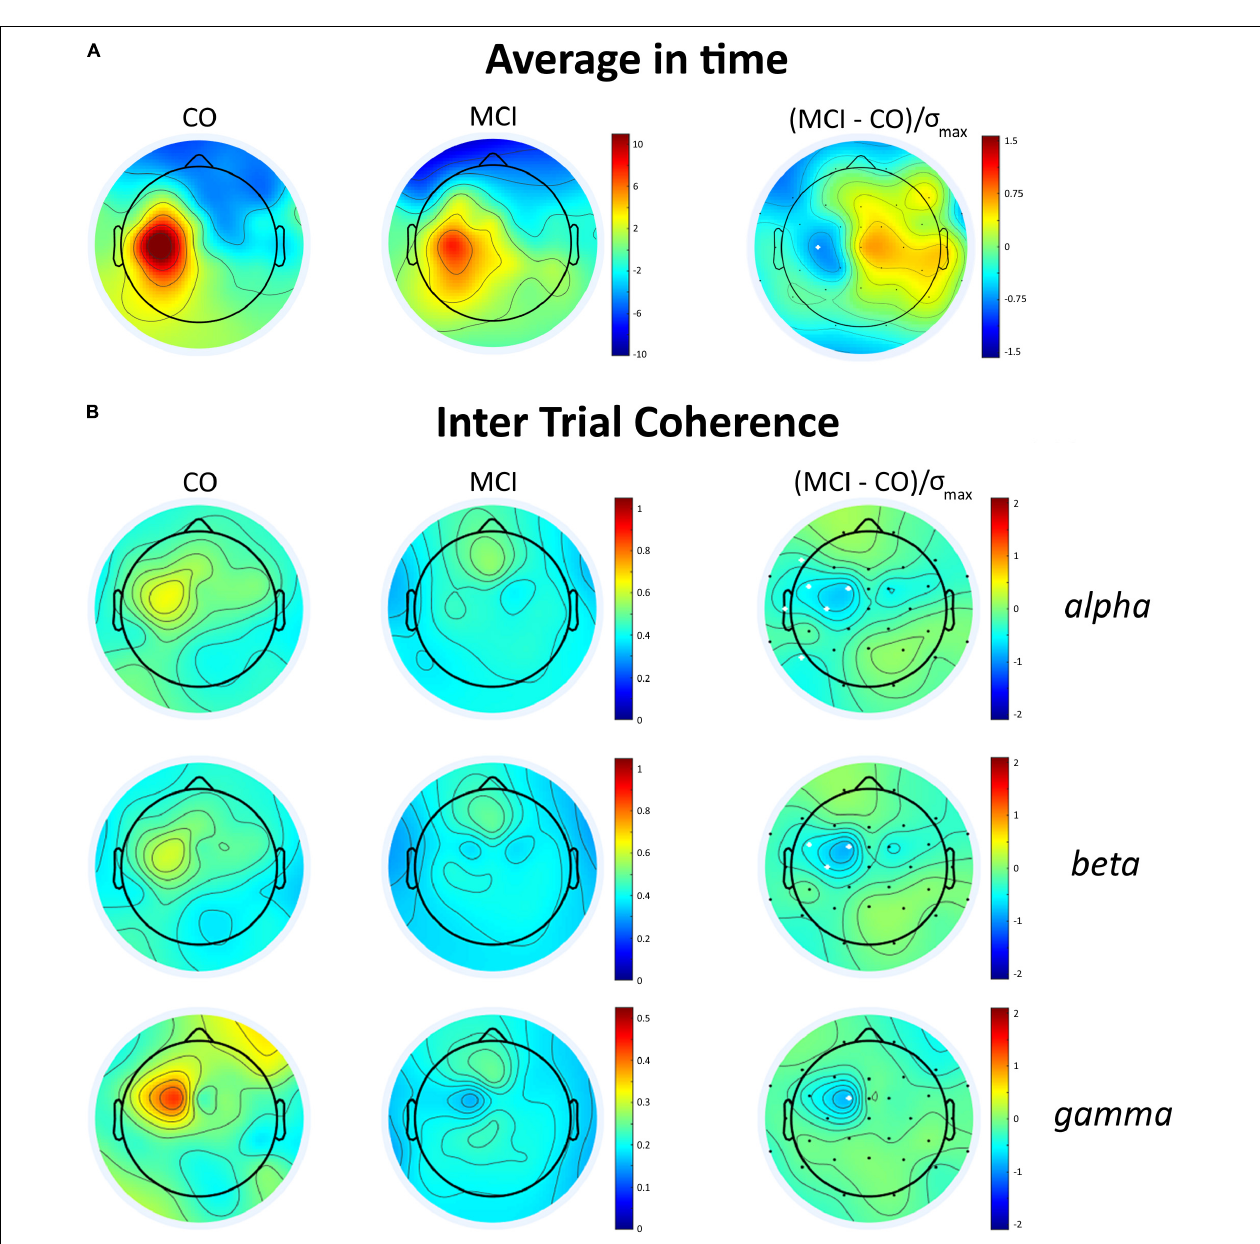
FIGURE 2 | Average integrated TMS-evoked activity and intertrial coherence (ITC) topography in the control subjects and the patients with aMCI. (A) Topographic distribution of the average integrated evoked responses in the healthy subjects (CO) and the patients with MCI for the time window 45–55 ms after the TMS over the left M1; the white dot represents the scalp position where the brain excitability is significantly decreased in the patients with aMCI, i.e., C3. (B) ITC in the alpha, beta and gamma bands in the time window of 35–145 ms post-TMS in CO and MCI and difference maps (right column). In the difference maps, the white dots represent the scalp position where ITC significantly decreased in the patients with